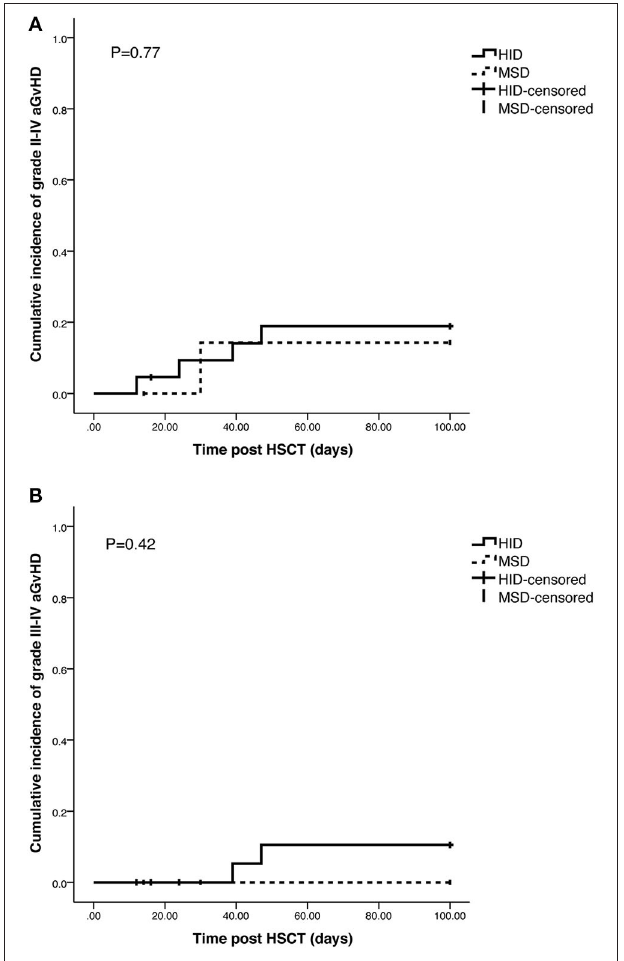
FIGURE 1 | Cumulative incidence of acute graft vs. host disease (aGvHD). (A) Cumulative incidence of Grade II–IV aGvHD in haploidentical donor (HID) cohort and in matched sibling donor (MSD) cohort. (B) Cumulative incidence of Grade III–IV aGvHD in HID cohort and in MSD cohort.